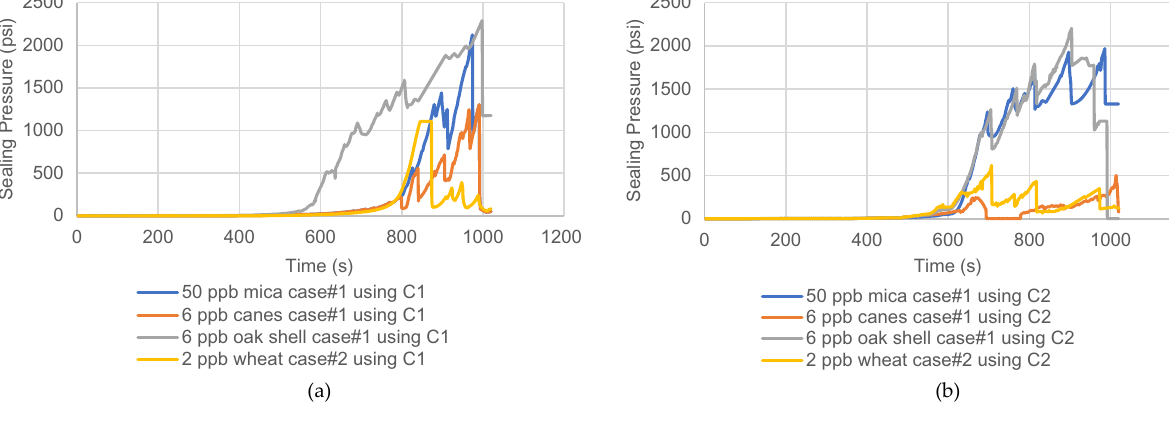
Fig. 28 HPA Pressure vs. Time plot for Mica, Canes, Oak Shell, and Wheat Straw showing maximum sealing pressure at the best particle size and concentration using C1 &